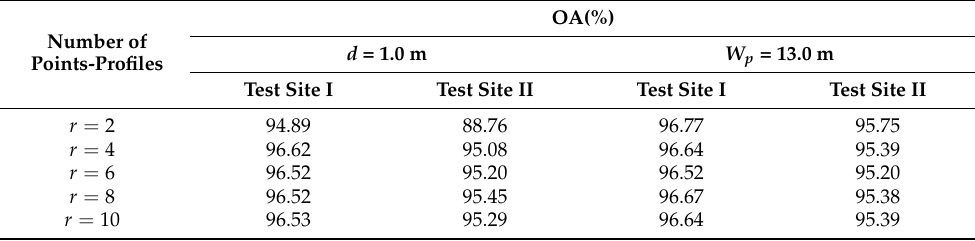
Figure 9. Some visualized results on large buildings in Test Site II of different network architectures. Points in red and blue denote the misclassified non-ground and ground points, respectively. Table 5. Influence of number of points-profiles in profile-stack r with fixed width of the profile-stack W p to 13